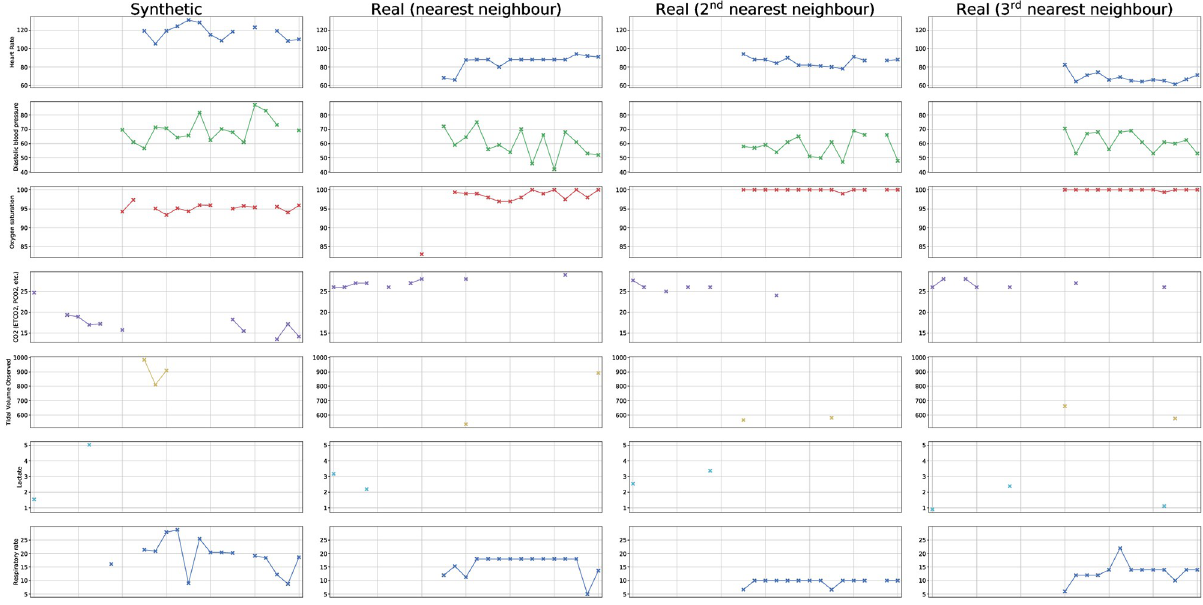
Fig 4. Comparison of the time series of a randomly sampled, synthetically generated patient and the corresponding time series of the three closest real patients (nearest neighbours) in the training data. While certain characteristics such as the number of missing values per feature or dynamics are similar between the synthetic sample and its nearest neighbours amongst the real data, we observe that the synthetically generated data is not a copy of the real data, indicating that our method does not memorize the data it sees during training. This experiment is merely meant to visually check if the generated data is an exact copy of the real data. The overall quality of the synthetic data is measured quantitatively by our evaluation scheme, not visually assessed here.